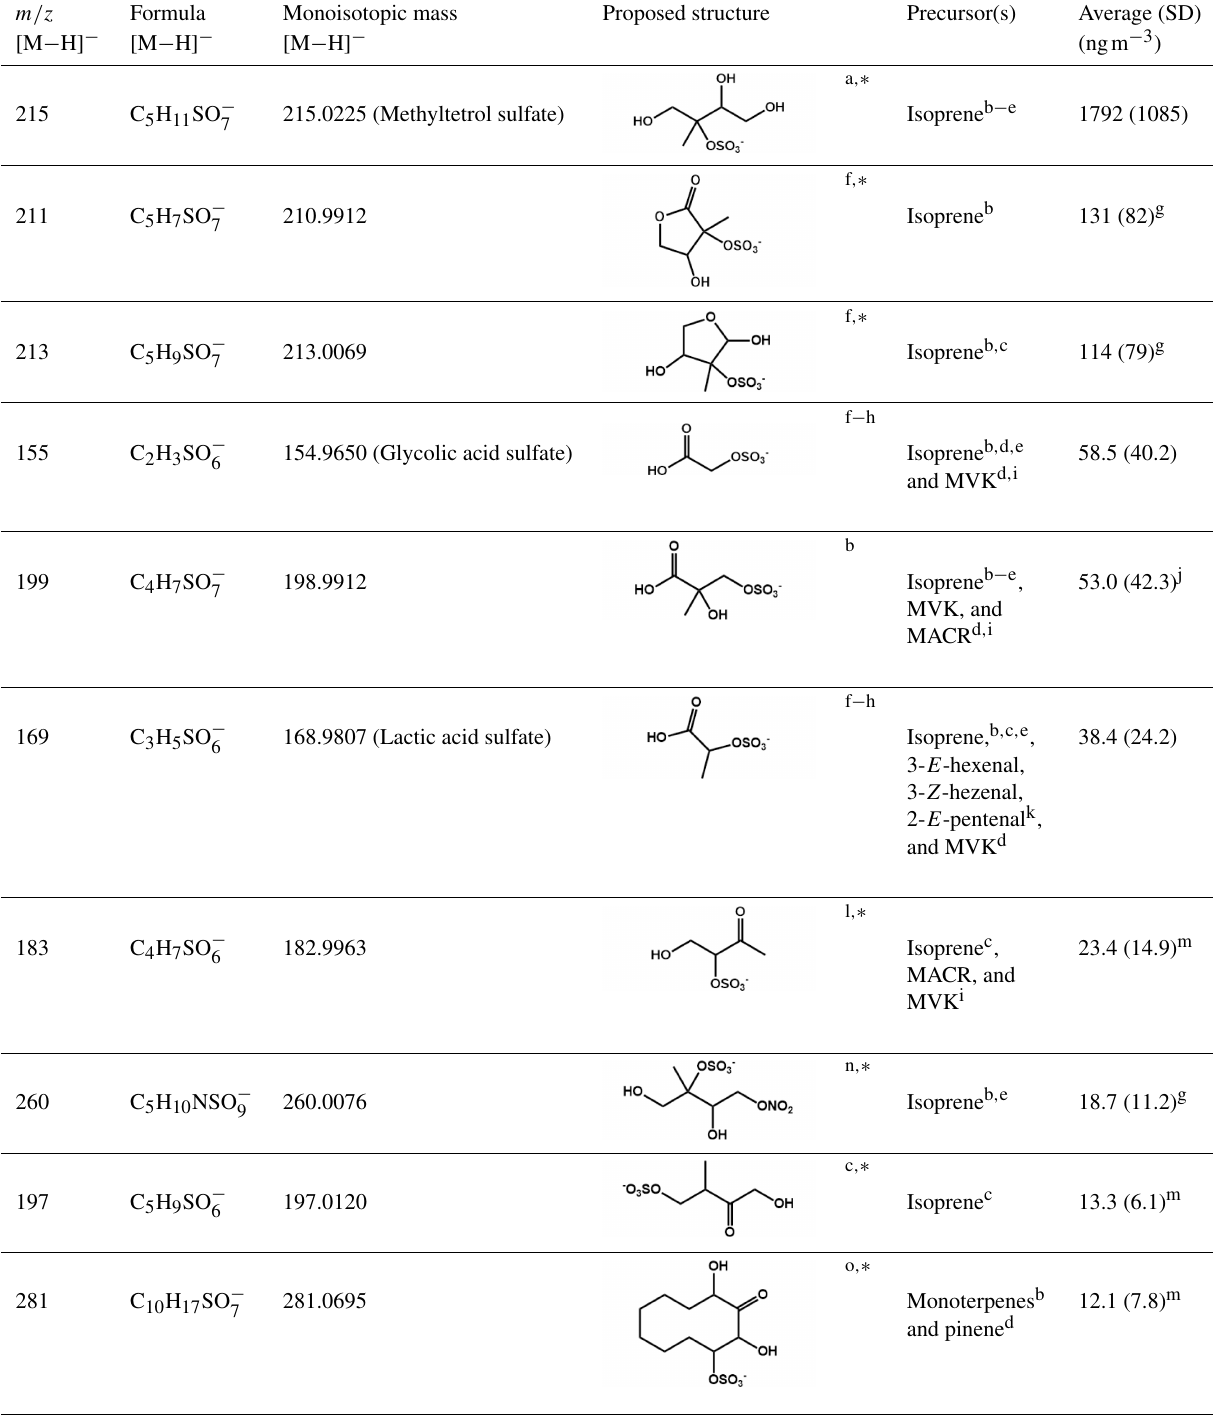
Table 1. The major organosulfates identified using HILIC-TQ in daily PM 2 . 5 samples collected from Atlanta, GA, in August 2015, indicating nominal mass-to-charge ratio ( m/z ), chemical formula, and monoisotopic mass determined from HILIC-ToF, proposed structure (with a star indicating many isomers, although only one is shown), potential VOC precursors, and their average ambient concentrations with one standard deviation (SD). For these organosulfates the median and the maximum error in the observed mass is 1.7 and 7.5mDa, respectively. Organosulfates are ordered in the table from greatest to lowest